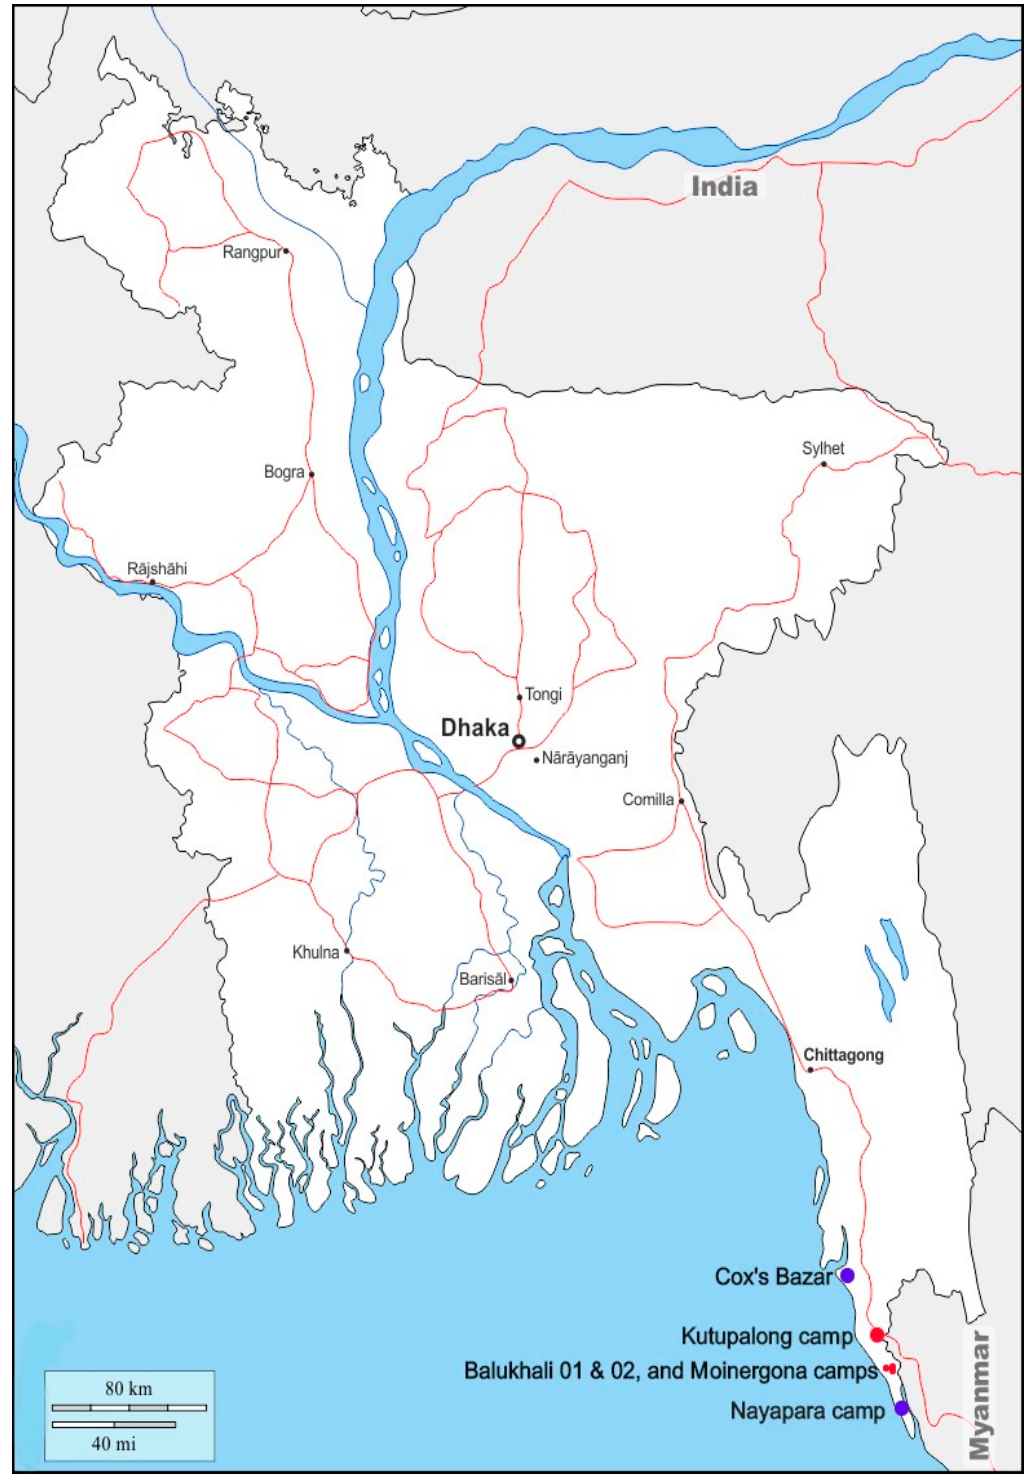
Figure 1. Map of Bangladesh showing Cox’s Bazar and study camps in red dots (source: https://d-maps.com).